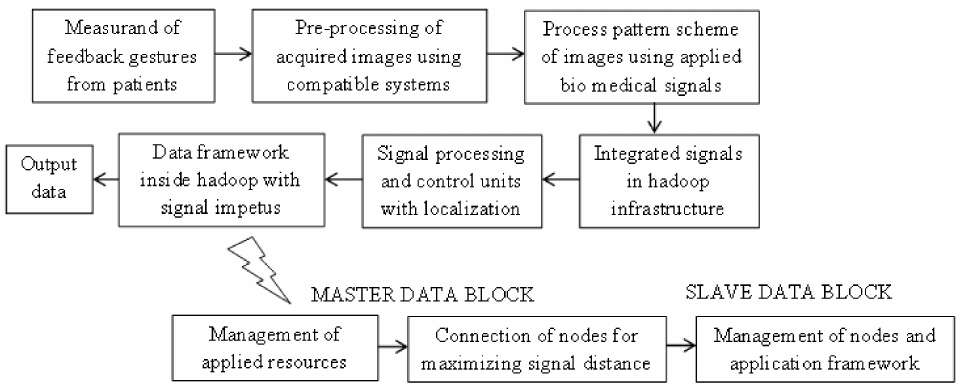
Figure 1. Block diagram of signal representation and processing using Hadoop